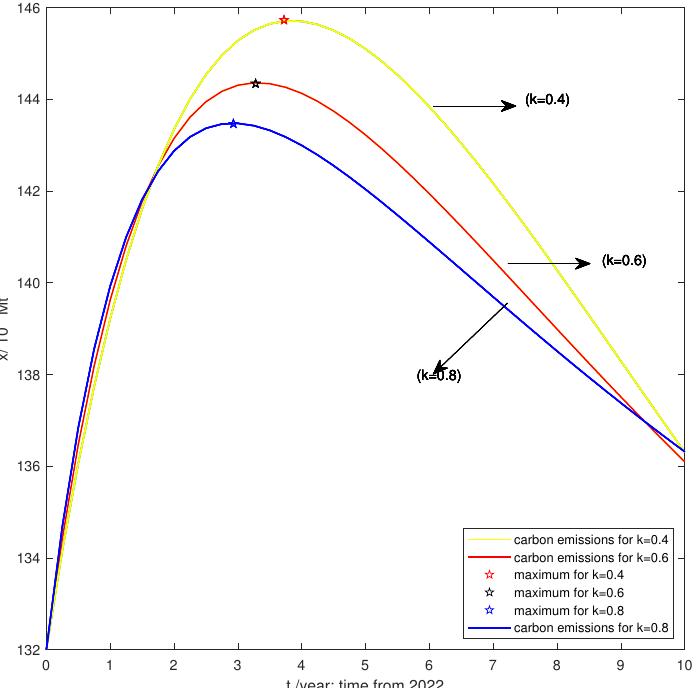
Figure 4. Change of carbon emission under different values for the influence coefficient of energy structure reform on carbon emissions amount k